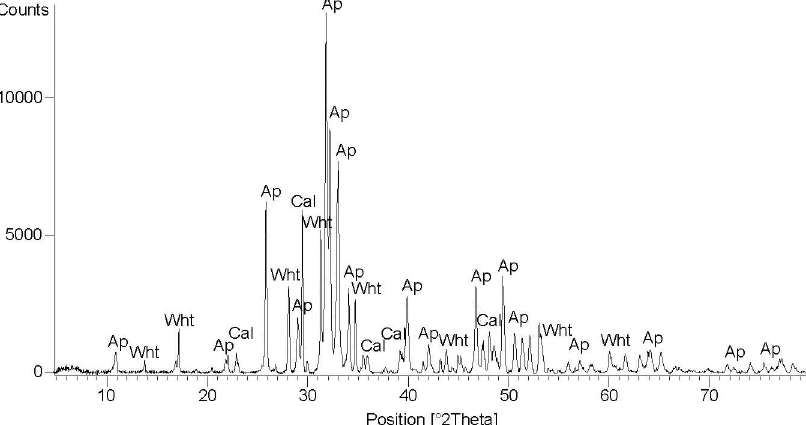
Fig 2. Mineralogical composition. X-ray diffraction pattern of stone S3: phase labels:Ap: apatite, Wht: whitlockite, Cal: calcite.